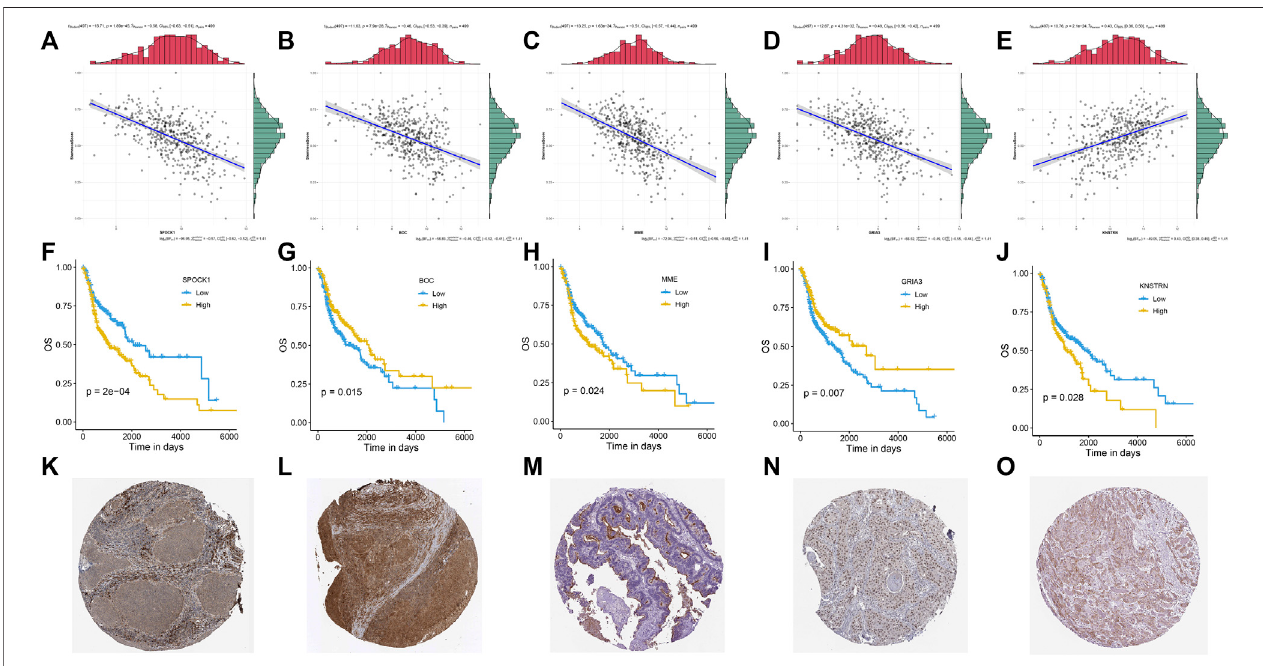
FIGURE 5 | Correlations between mRNA expression and stemness score of fi ve stemness-related genes: SPOCK1 (A) , BOC (B) , MME (C) , GRIA3 (D) , and KNSTRN (E) .Kaplan-Meiercurvesof fi vegenesignatures:SPOCK1 (F) ,BOC (G) ,MME (H) ,GRIA3 (I) ,andKNSTRN (J) .Theexpressionpro fi lesoftheproteinsencoded by SPOCK1 (K) , BOC (L) , MME (M) , GRIA3 (N) , and KNSTRN (O) . p value < 0.05 was